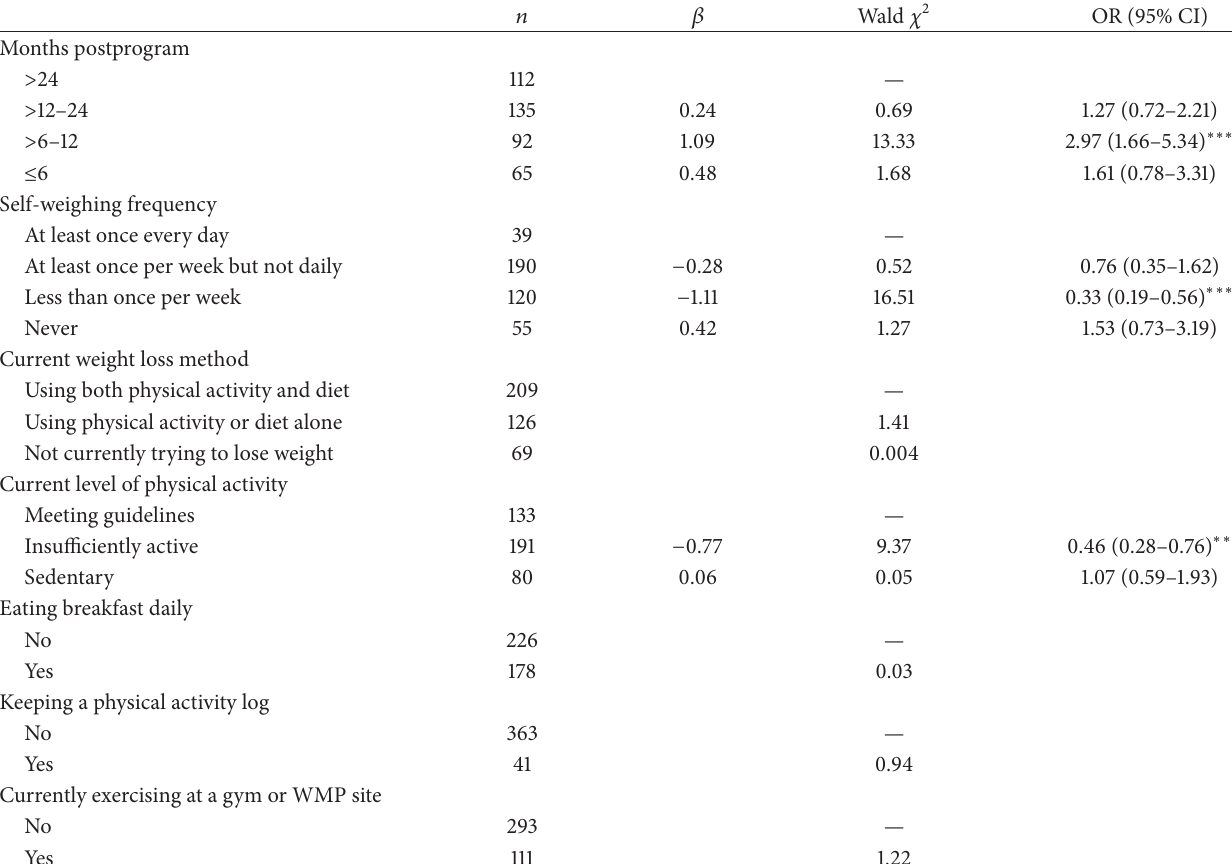
Table 4: Postprogram predictors of weight loss maintenance ( 𝑁 = 404 )—Model